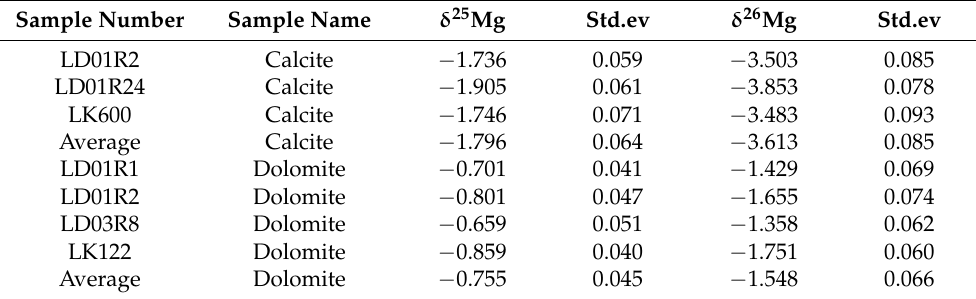
Table 3. Mg isotopic composition of hydrothermal calcite/dolomite in Lekai Pb-Zn deposit.